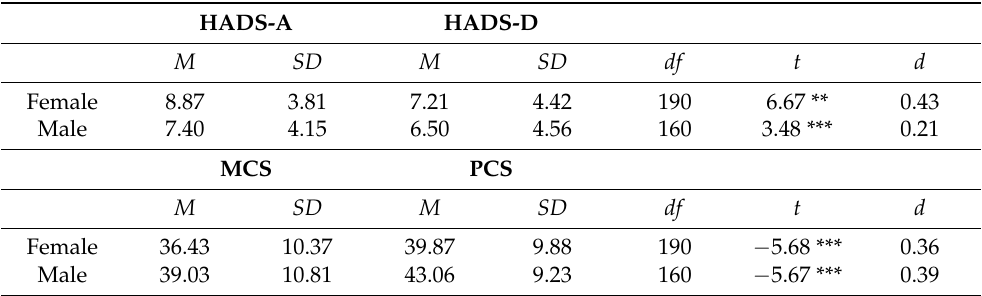
Table 4. Within-gender differences for anxiety vs. depression, and mental vs. physical HRQoL (paired-samples t -tests).